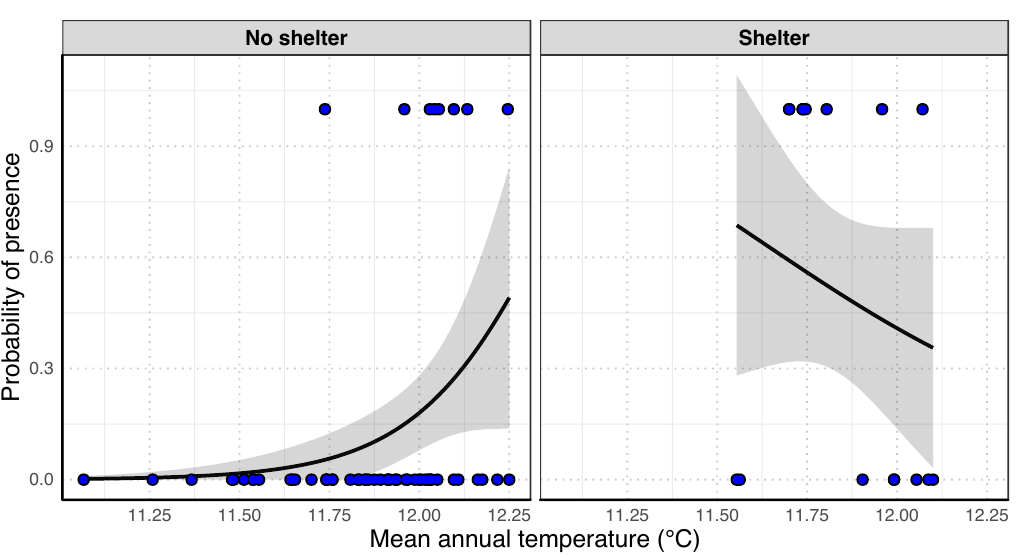
Figure 4. Predicted relationships between the presence-absence of Orconectes limosus and the mean annual temperature in interaction with the presence of shelters. Shaded grey surfaces are 95% confidence intervals. Blue dots are observed